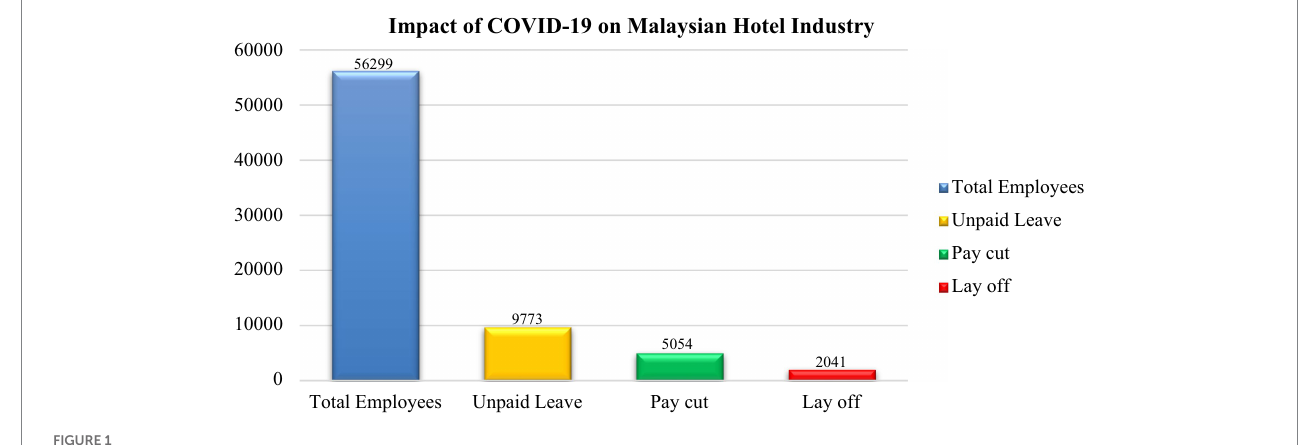
FIGURE 1 Impact of COVID-19 on the Malaysian Hotel Industry. The Star